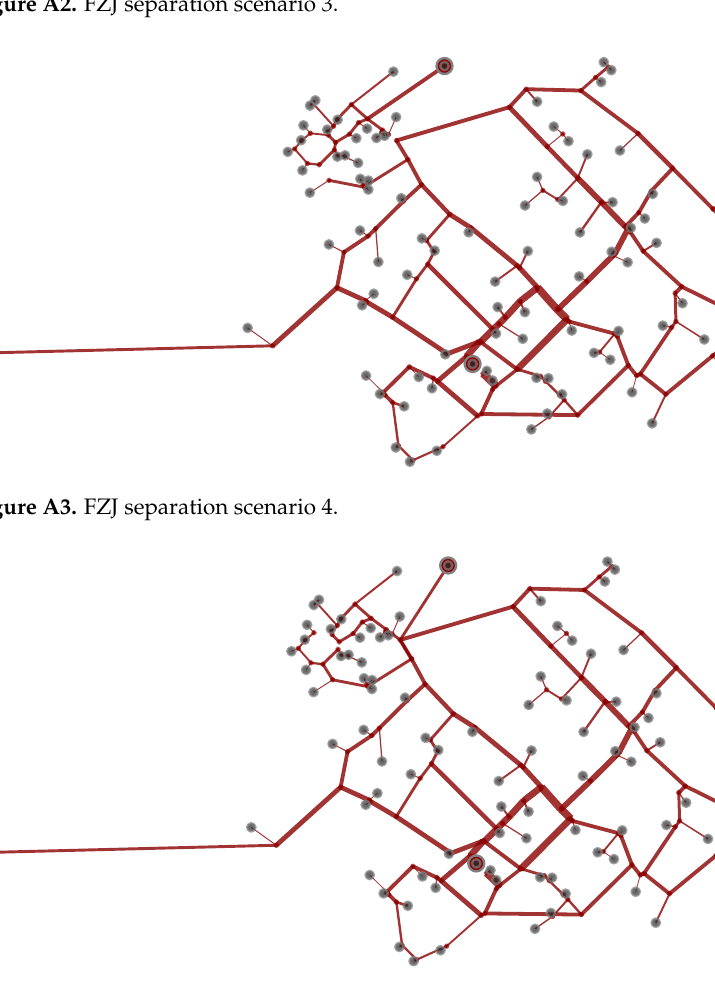
Figure A4. FZJ separation scenario